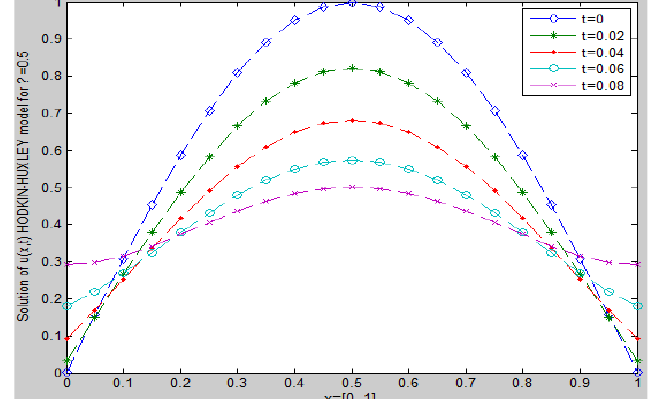
Fig. 7. Solution of Fitzhugh-Nagumo Equation, when 𝛼 = 0, 𝜀 = 𝛽 = 1; 𝛾 = (0,1) by VIMLW